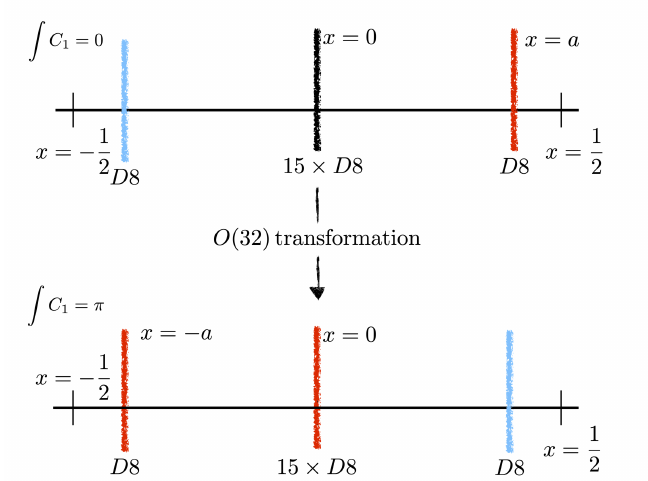
Figure 1 . The type I’ theory describes D 8 branes on an interval, depicted here as the real line R subject to periodic identifications. O 8 − planes are found at x ∈ Z / 2 . The top section of the figure describes 15 D 8 branes sitting at the origin and a single D 8 brane moved to x = a . There is no Wilson line. Thanks to the anomaly described in the main text, acting with an O (32) transformation flips the position of the D 8 brane to x = − a and introduces a discrete Wilson line. Since the brane at x = − a can also be obtained simply by moving the D 8 to the left, we discover that the discrete Wilson line is not an invariant